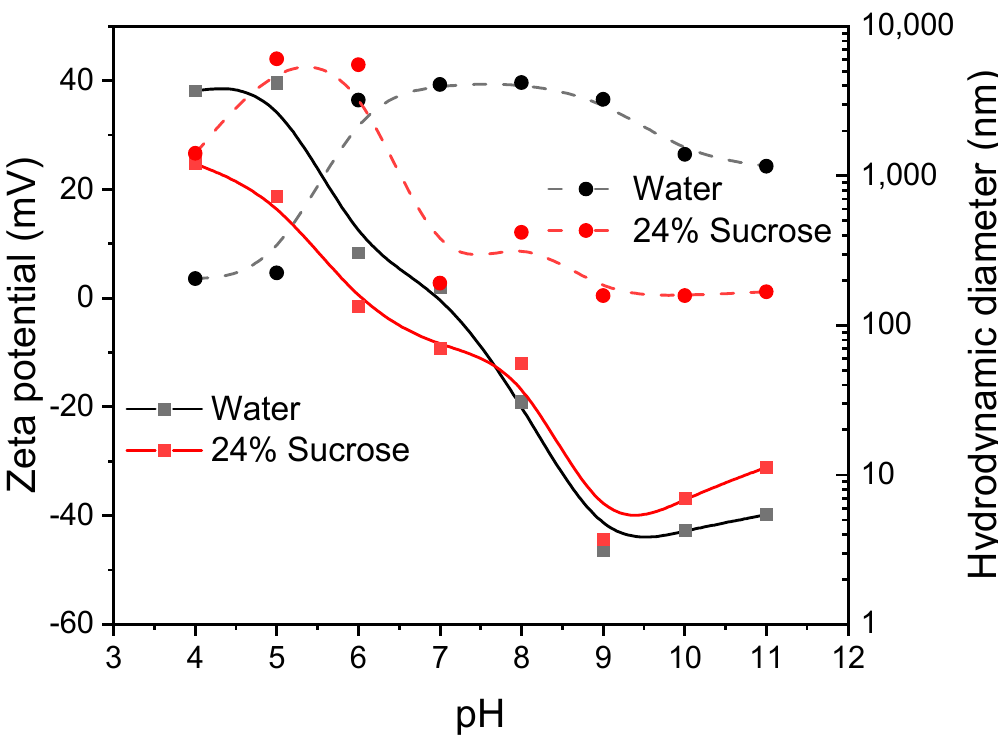
Figure 3. Zeta potential and DLS of iron oxide nanoparticles (2 g/L) over the pH range 4–11 at 25 °C in deionized water and sucrose containing water (24.4 w%).